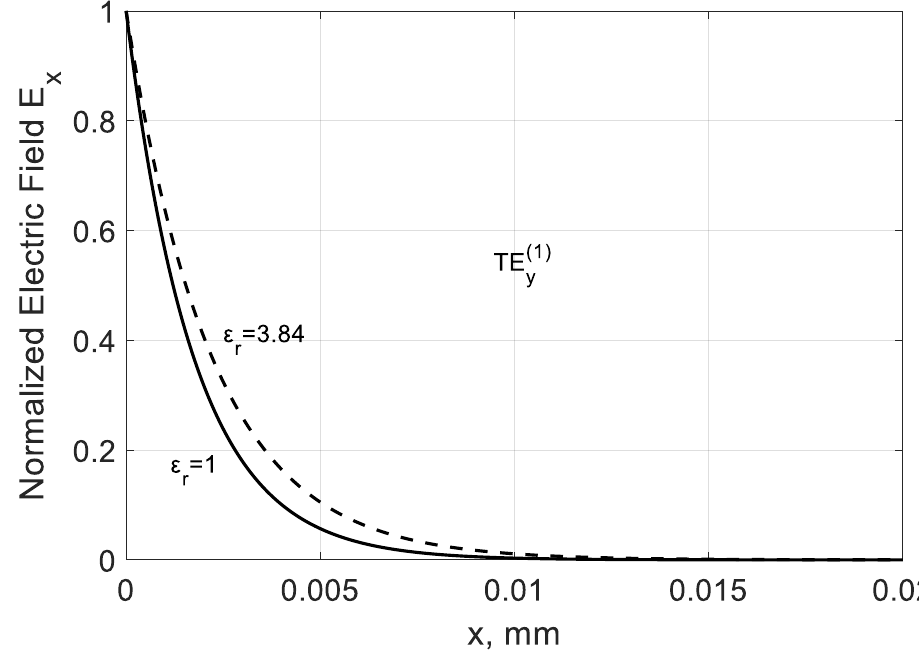
Figure 17. Mode field dependence E x along the x − direction in a graphene H-waveguide of the height b = 0.01 mm and width 2 a = ∞ calculated for the dielectrics with ε r = 1.0;3.84 and µ r = 1 at frequency F = 4000 GHz. Parameters used for calculation of σ g are from Ref. [21]: T = 300 K, E F = 40 meV, and τ = 1 ps.